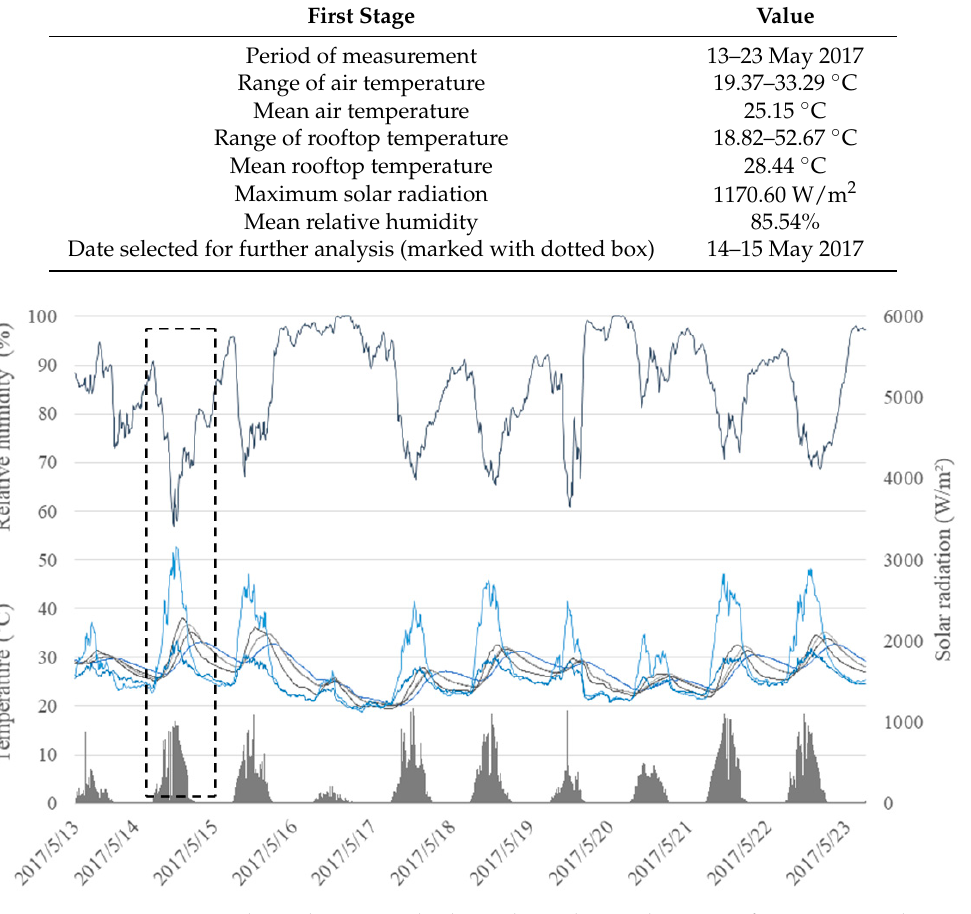
Figure 5. Temperatures, solar radiation, and relative humidity in the cases of 10, 15, 20, and 25 cm conventional garden-soil roofs without plants (13 May 2017 05:59:44 to 23 May 2017 05:49:44).